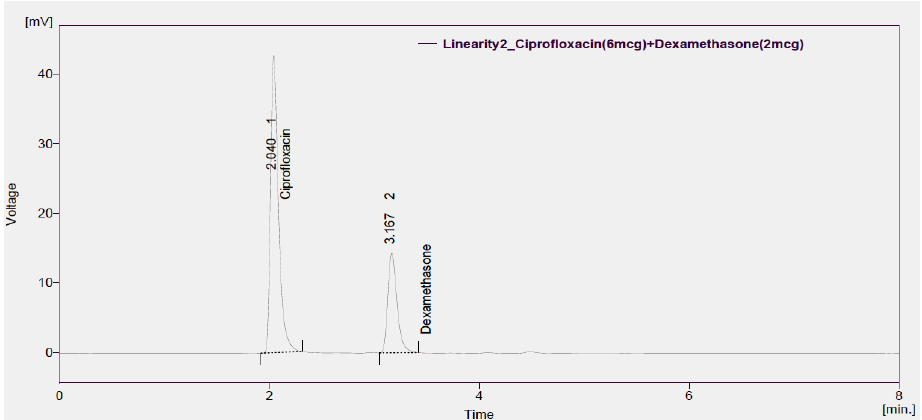
Figure 2: Typical chromatogram for the standard solution of CFH and DSP.